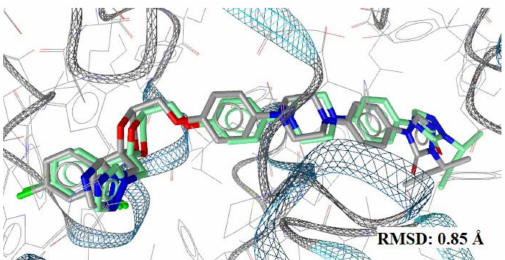
Figure 8. Docking of the initial inhibitor to the 5V5Z